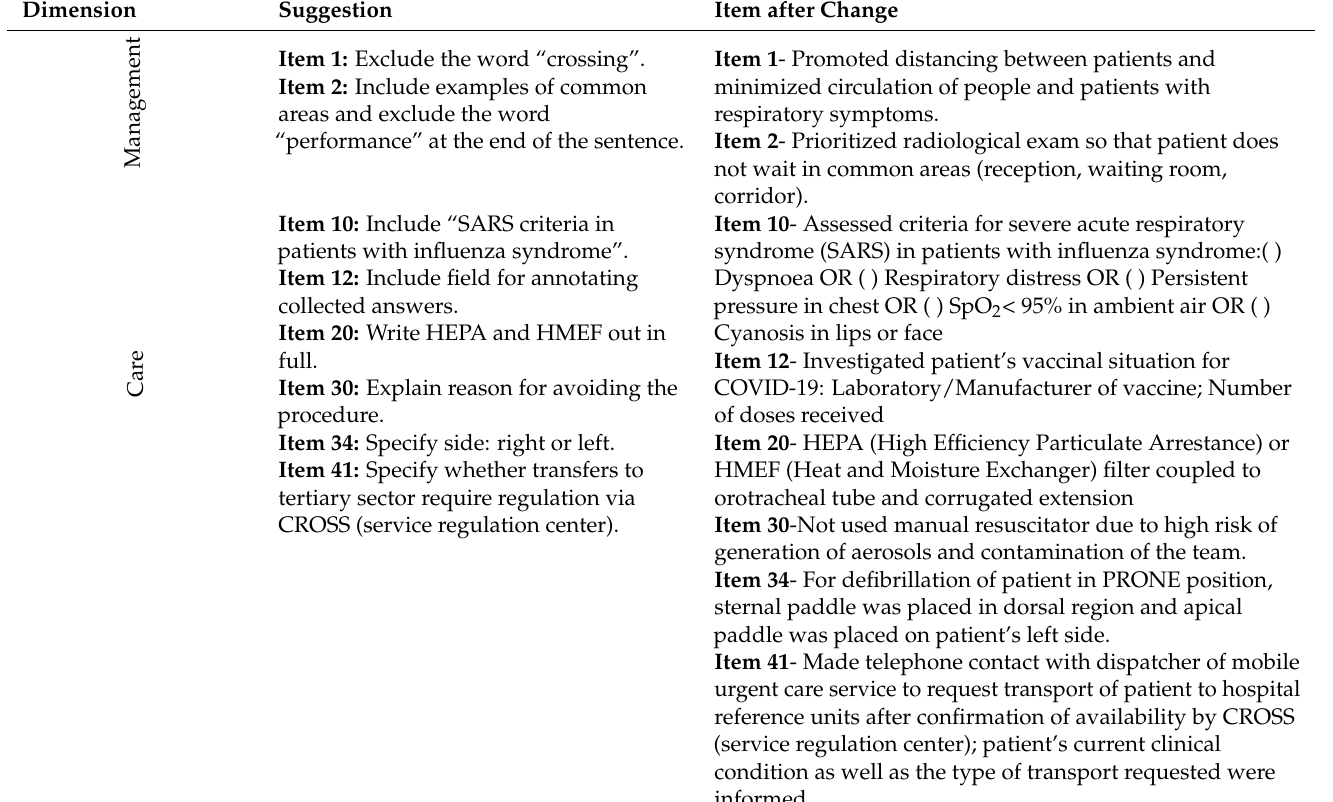
Table 2. Summary of suggestions made for times on instrument after evaluation of group of